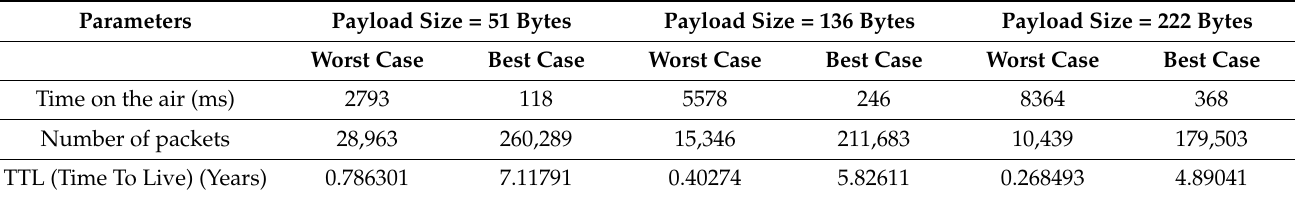
Table 10. Battery lifetime in the case of the proposed protocol extremly low power authentication case 2 for different message sizes (10 bytes overhead due to